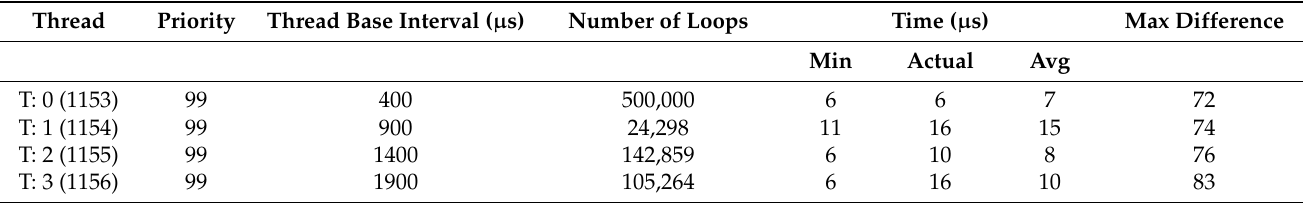
Table 1. Cyclictest latency of Debian Linux kernel version 4.19.67-2 with the PREEMPT_RT patch.